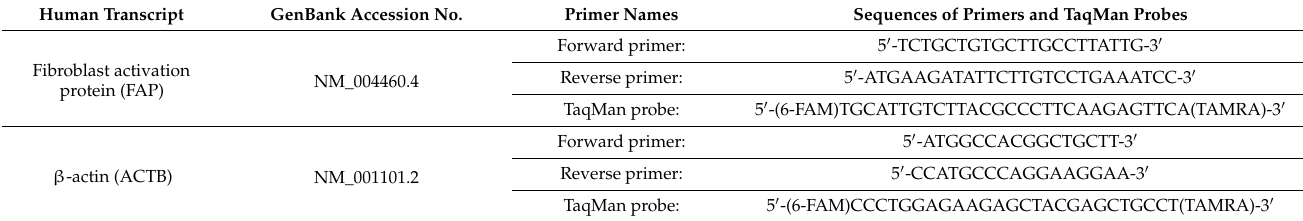
Table 3. Primers and TaqMan probes for real-time RT-PCR quantification of expression of human FAP and ACTB mRNAs. Human